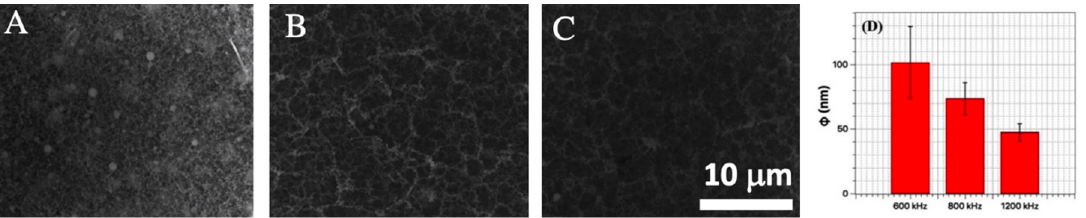
Figure 6. ( A ) Theoretical ablation depth profile as a function of radius and ( B ) theoretical ablation depth profile as a function of laser scanning speed for single pulsed laser with frequency of 600, 800 and 1200 kHz.